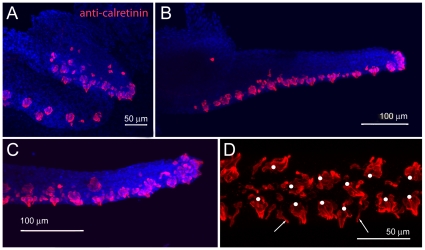
Maxillary barbel taste bud development.
A) 150 µm barbel. Whole-mount immunohistochemistry (anti-calretinin) shows numerous differentiated taste buds (red) on the ventral surface and distal tip of the early barbel bud. Nuclei are counterstained blue (DAPI stain). B) 400 µm barbel. Teardrop-shaped clusters of calretinin positive cells line the ventral surface. C) Magnification of the maxillary barbel tip. D) Ventral view of the mature maxillary barbel. Teardrop-shaped taste buds (white dots) are arranged in pairs along the ventral surface. Scattered solitary chemosensory cells (SCCs, white arrows) are visible between the taste bud clusters.